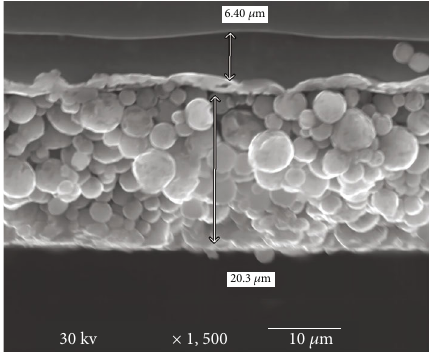
Figure 1: SEM image of BSF formed by Al paste